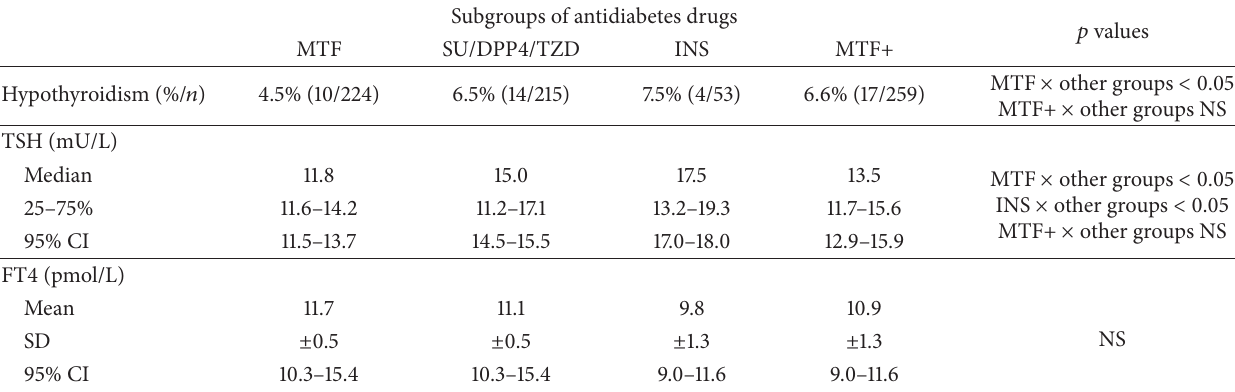
Table 4: Prevalence of hypothyroidism, TSH, and FT4 in subgroups of hypothyroid patients with diabetes.